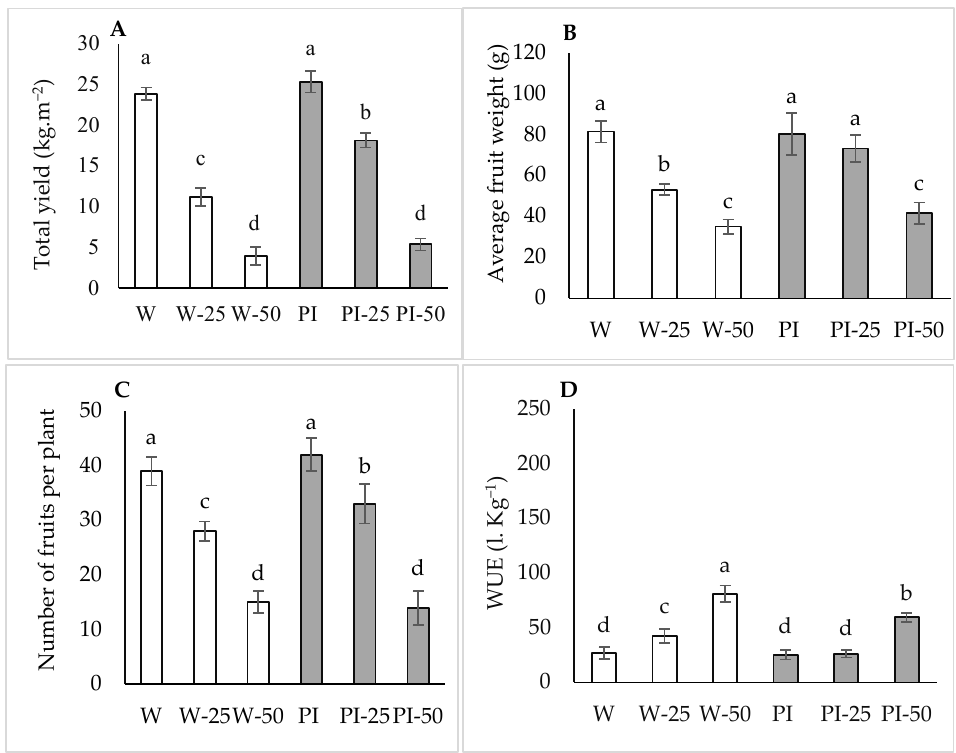
Figure 3. ( A ) Total yield, ( B ) average fruit weight, ( C ) number of fruits per plant, ( D ) water-use efficiency (WUE) of cucumber grown under well and limited water irrigation regimes. W (normal irrigation), W-25 (moderate water stress; equal 25% less than normal irrigation), W-50 (severe water stress; equal 50% less than normal irrigation), PI (inoculation with P. indica under normal irrigation), PI-25 (inoculation with P. indica under 25% less than normal irrigation), and PI-50 (inoculation with P. indica under 50% less than normal irrigation). Data are means of combined analysis of two growing seasons. Means marked by the same lower-case letter are not significantly different ( p < 0.05). Error bars represent standard error of the means (SE), n = 24.